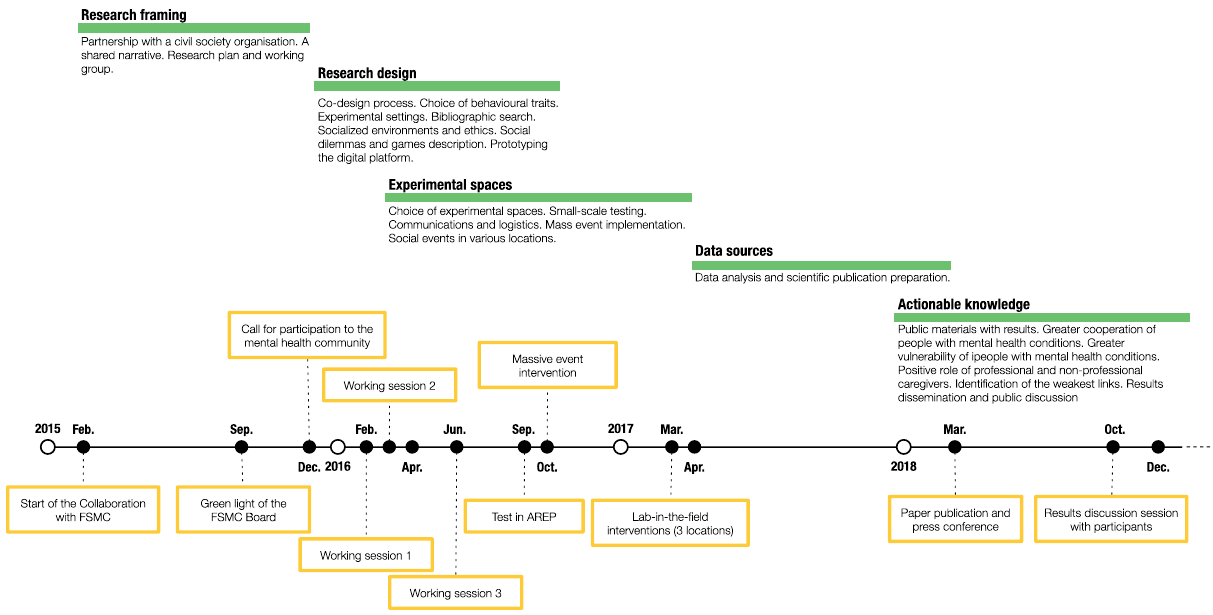
Fig. 1 Timeline of “ Games for Mental Health ” . Events and tasks are related to the timeline and the key steps of the research process: research framing, research design, experimental spaces, data sources and actionable